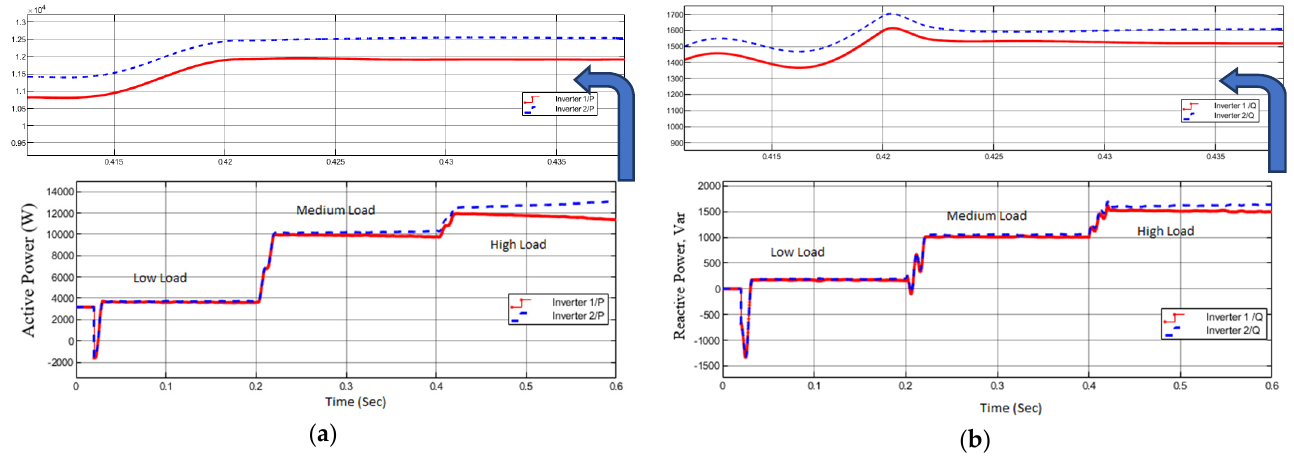
Figure 19. Output power of the inverter when low, medium, and high loads are supplied using PSO droop control for: ( a ) Active power; ( b ) Reactive power.